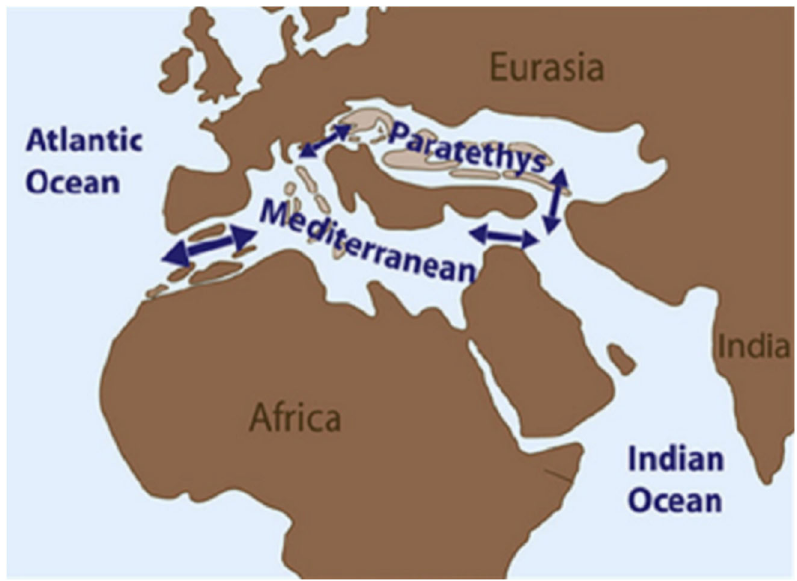
Figure 18. Marine connections and migration routes among the marine realms during the Miocene Epoch